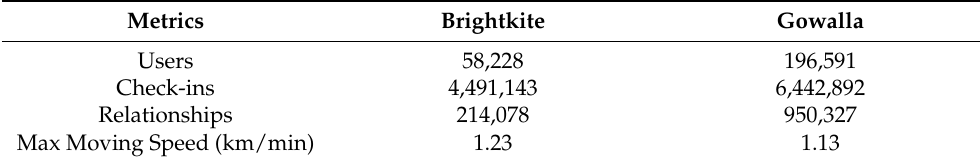
Table 2. Specific metrics for Brightkite and Gowalla datasets.